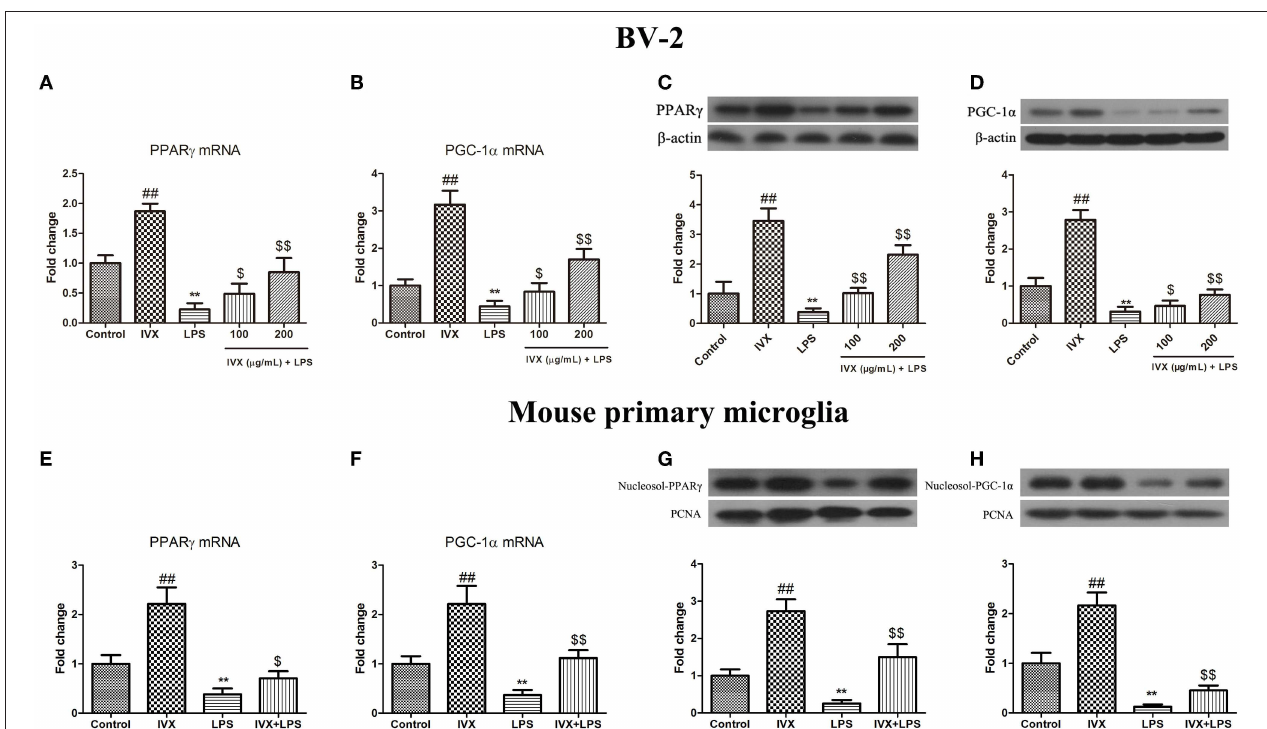
FIGURE 2 | IVX suppressed the mRNA and protein expression of PPAR γ and PGC-1 α in LPS-activated BV-2 cells and mouse primary microglia. (A,B,E,F) RT-PCR revealed that IVX up-regulated the mRNA expression of PPAR γ and PGC-1 α in LPS-activated BV-2 cells and mouse primary microglia. Cells were pretreated with IVX (200 µ g/mL) for 2h and then stimulated with LPS (100ng/mL) for 6h. (C,D) Western blotting revealed IVX enhanced the protein expression of PPAR γ and PGC-1 α in LPS-activated BV-2 cells. BV-2 cells were pretreated with IVX (200 µ g/mL) for 2h and then stimulated with LPS (100ng/mL) for 12h. (G,H) Western blotting revealed IVX enhanced the nuclear protein expression of PPAR γ and PGC-1 α in LPS-activated mouse primary microglia. Cells were pretreated with IVX (200 µ g/mL) for 2h and then stimulated with LPS (100ng/mL) for 12h. The experiments were conducted in triplicate and repeated at least three times. Values are expressed as mean ± SEM ( n = 4 in each group). ## p < 0.01, vs. control group; ** p < 0.01 vs. control group; $ p < 0.05 and $$ p < 0.01 vs. LPS group.